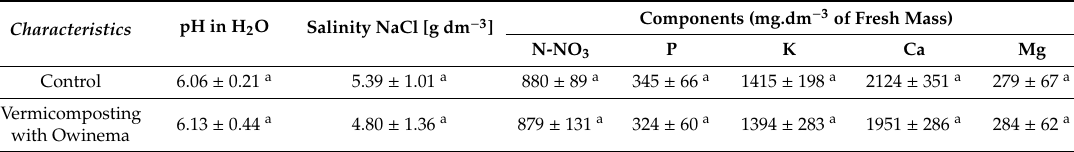
Table 5. Characteristics of the vermicompost obtained from organic waste (components marked in fresh mass, at vermicompost humidity of 70%).